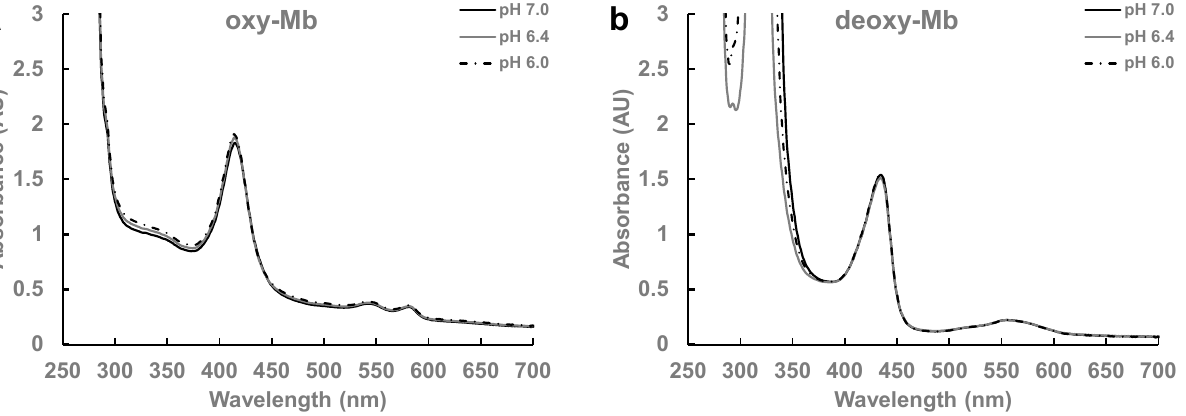
Figure 6. A representative UV-Vis spectra of freshly prepared ( a ) oxy-Mb and ( b ) deoxy-Mb samples each at pH 7.0, pH 6.4, and pH 6.0. Preparation of protein samples is detailed in the Materials and Methods section. All the spectra were repeated 3 times ( n = 3).